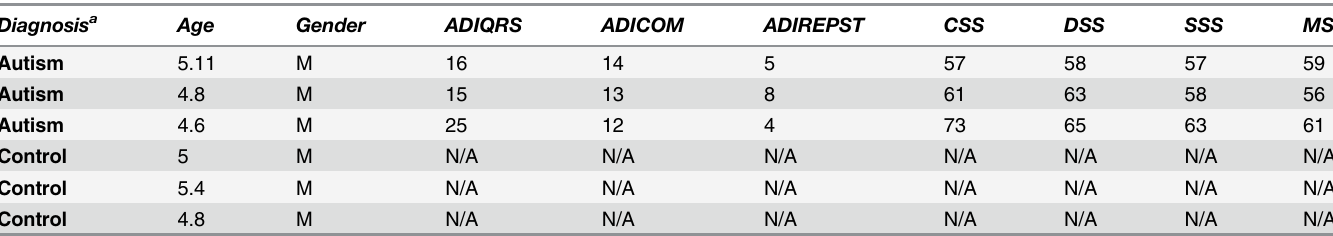
Table 2. Description of sera used for fi nal in vitro and in vivo analyses Diagnosis